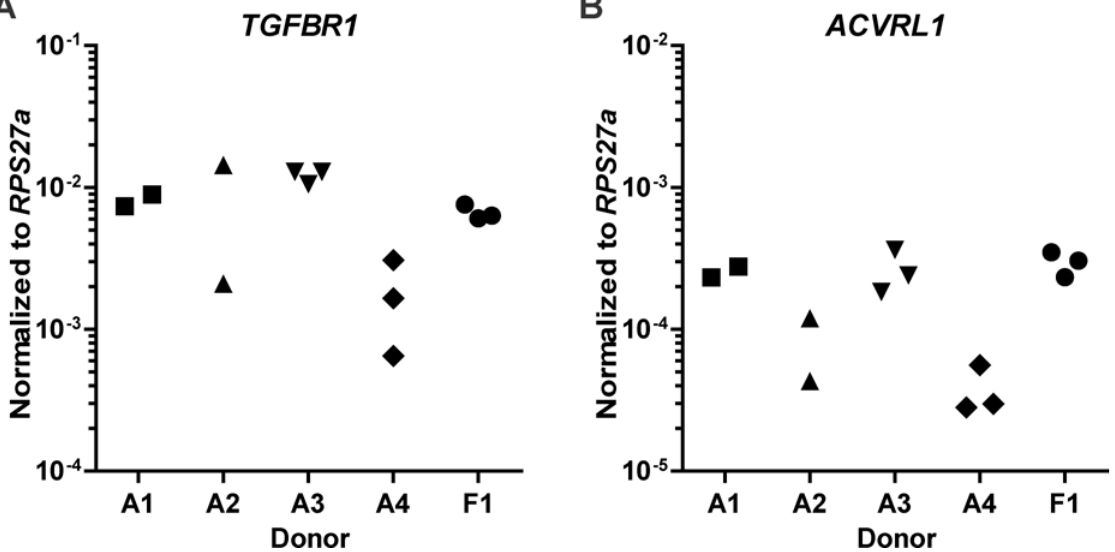
Fig 1. ALK5 and ALK1 are expressed in human bone marrow-derived mesenchymal stem cells (BMSCs). In human BMSCs, obtained from four adult donors (A1 – A4) and one fetal donor (F1), gene expression levels of ALK5 (= TGFBR1) (A) and ALK1 (= ACVRL1) (B) were analyzed using RT-qPCR. Gene expression was normalized to reference gene RPS27a . Each data point represents one